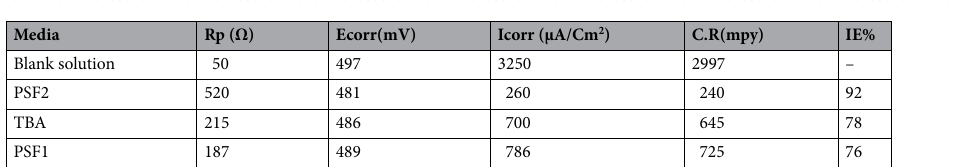
Table 2. List of potentiodynamic polarization descriptors for mild steel exposed to 1.0 M H 2 SO 4 without and with different inhibitors.